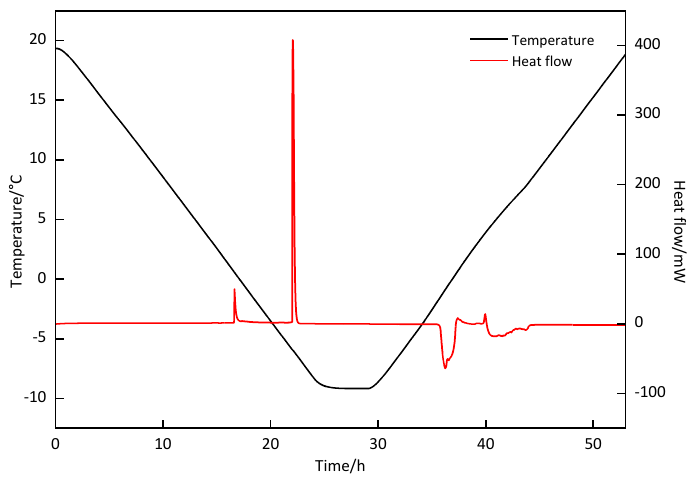
Figure 10. Heat flow and temperature curve at 20.0~ −8.8 °C and 3.5 MPa.